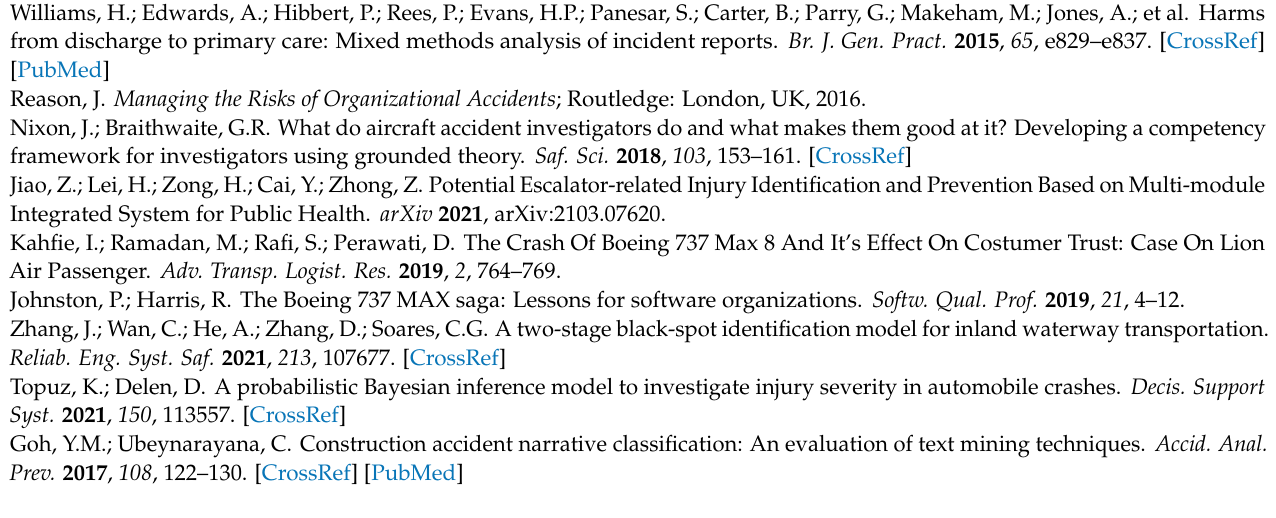
Funding: Figure 2 was modified from ’BERT: Pre-training of Deep Bidirectional Transformers